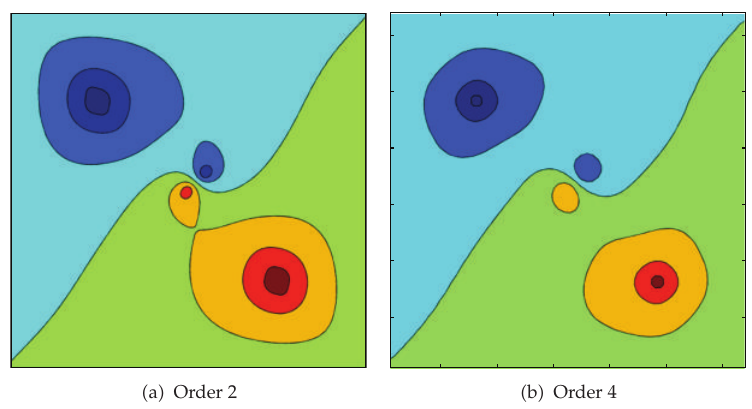
Figure 12: Error di ff erence, d , for second- and fourth-order synthetic fields.